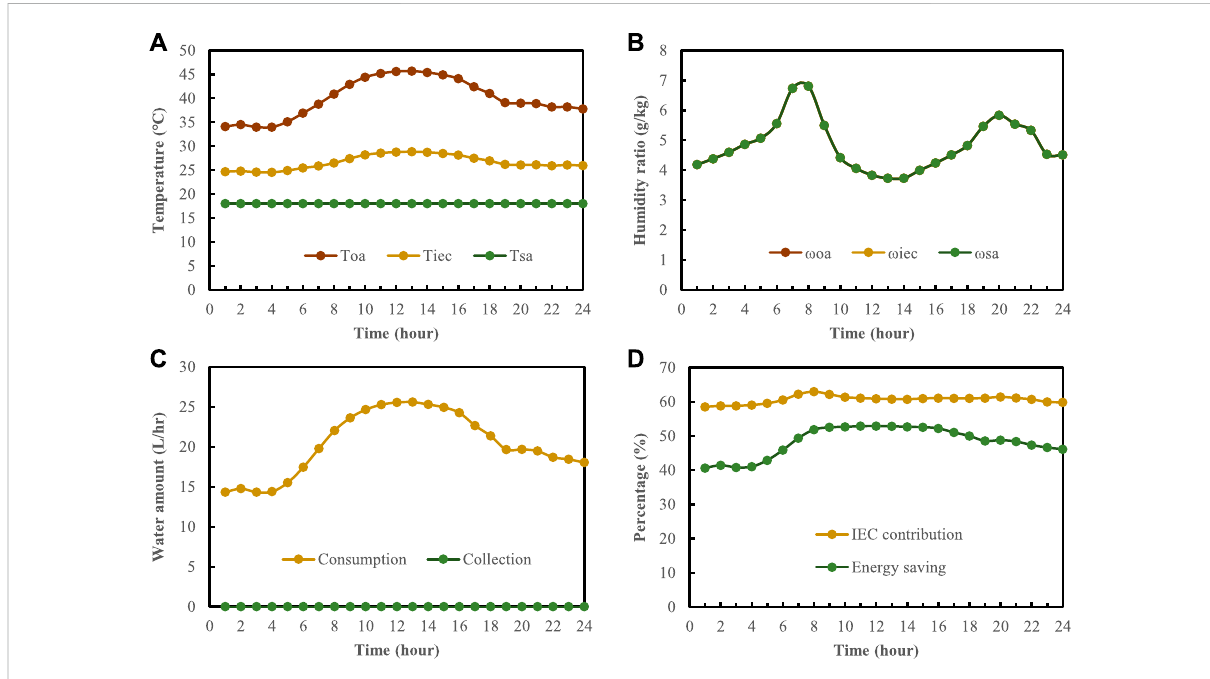
FIGURE 7 Daily performance of IEC-MVC in Riyadh on Jul-27 2021: (A) temperature change, (B) humidity change, (C) water collection and consumption, and (D) ∅ IEC and energy saving.